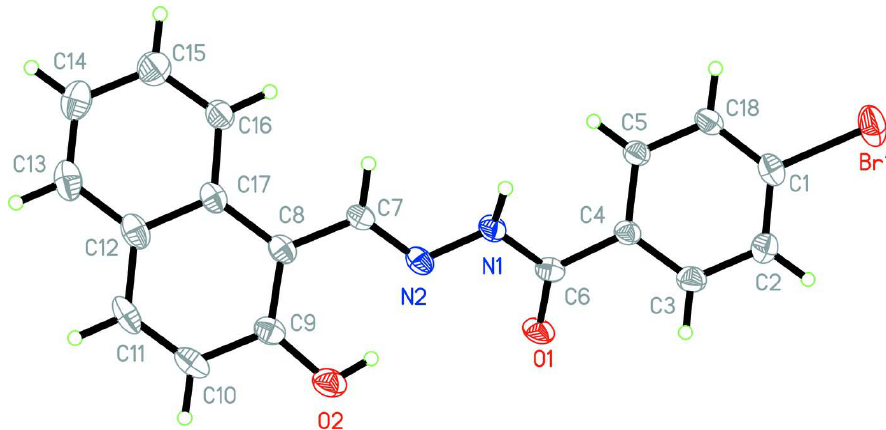
Figure 1 The molecular structure of the title compound with displacement parameters drawn at the 30% probability level.